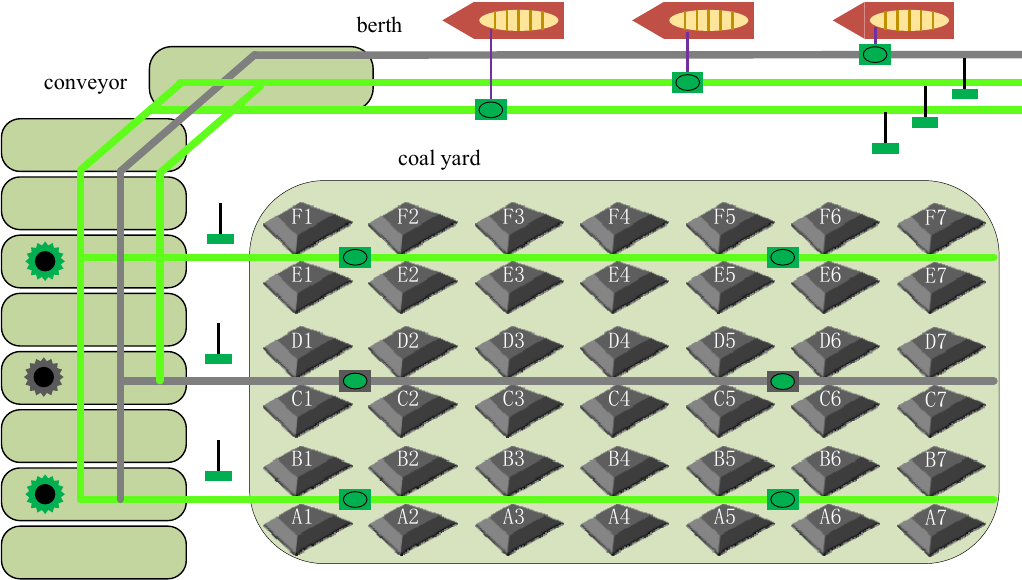
Figure 1. Port coal transfer process.